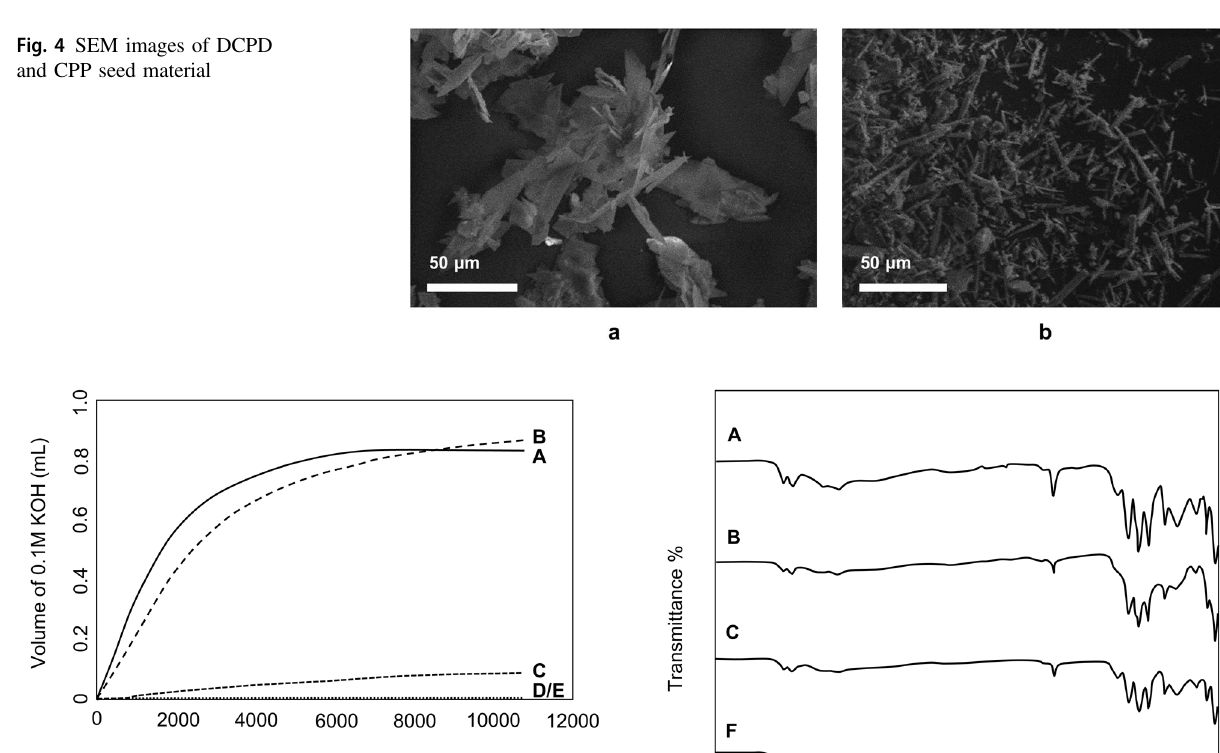
Fig. 4 SEM images of DCPD and CPP seed material